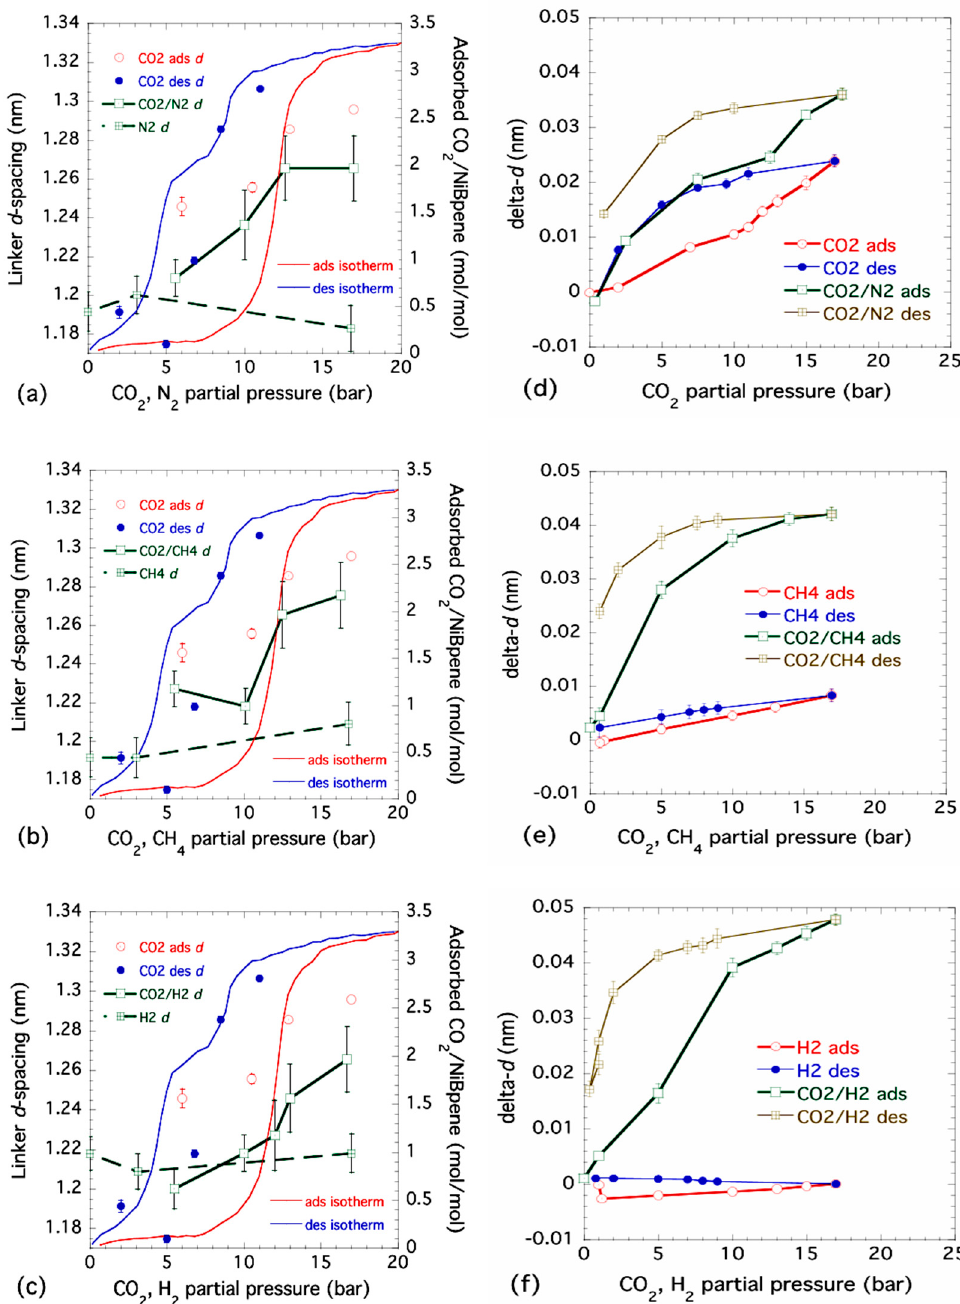
Figure 2. Variations in Bpene linker d -spacing with either pressure (pure gas) or partial pressure (dual gas). ( a ) N 2 and CO 2 /N 2 , ( b ) CH 4 and CO 2 /CH 4 , and ( c ) H 2 and CO 2 /H 2 , show ND-based results under static gas pressure conditions, superimposed on measured CO 2 adsorption/desorption isotherms measured at 30 ◦ C. These plots show changes in d -spacing for pure CO 2 adsorption (CO 2 ads d ) and desorption (CO 2 des d ). Additional points and lines refer to either pure gases (indicated) or dual gas combinations with CO 2 (adsorption only). ( d ) CO 2 and CO 2 /N 2 , ( e ) CH 4 and CO 2 /CH 4 , and ( f ) H 2 and CO 2 /H 2 show XRD-based results for changes in Bpene linker d -spacing under gas flow conditions at ≈ 30 ◦ C. These plots show changes in d -spacing for both adsorption (ads) and desorption (des) for pure gases and also dual gas combinations. In ( a ) to ( f ), vertical bars are computed standard deviation uncertainties based on Gaussian (ND) or Lorentzian (XRD) peak fits to the linker d -spacing